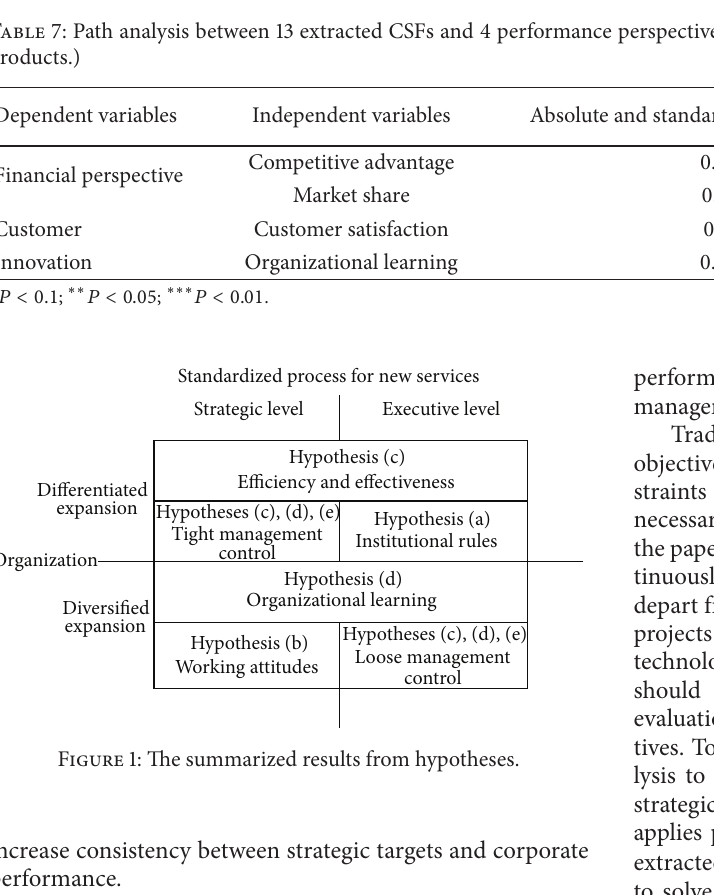
increase consistency between strategic targets and corporate